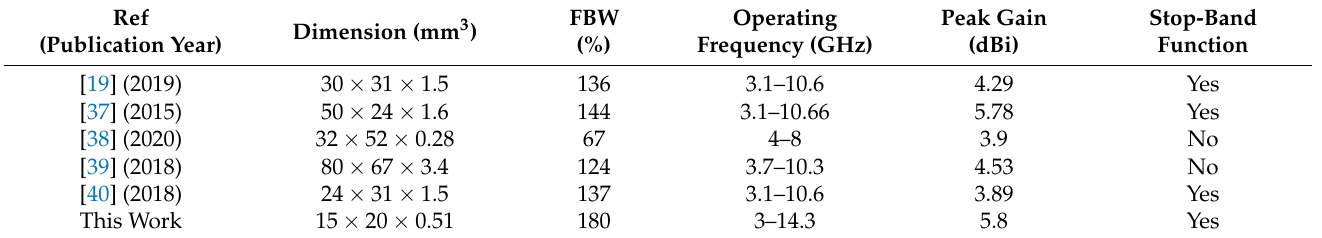
Table 2. Performance comparison with state-of-the-art